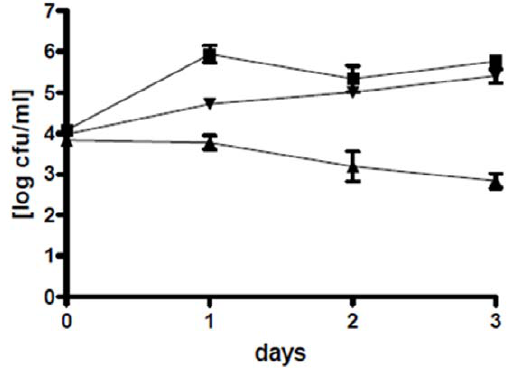
Figure 5. Influence of bacterial strains on rotifer growth. Rotifer numbers in co-culture with P. gallaeciensis wild type ( . ), with the TDA- negative mutant of P. gallaeciensis ( ¤ ), with only V. anguillarum ( m ), and axenic rotifers ( & ), first experiment. All bacteria were inoculated at day 0. Both P. gallaeciensis strains promoted rotifer growth, whereas V. anguillarum had no influence.